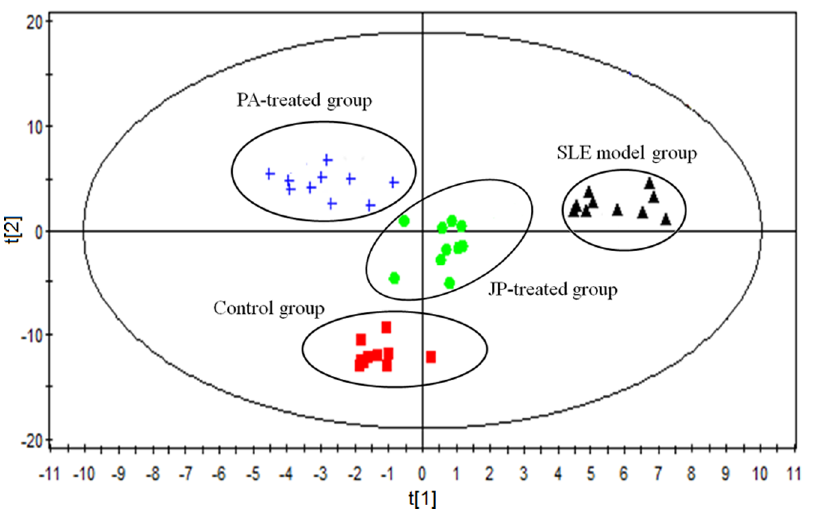
Figure 6. OPLS score plot of the SLE model group, PA-treated group, JP-treated group and control group by SIMCA-P11.0 (n=10 in each group).